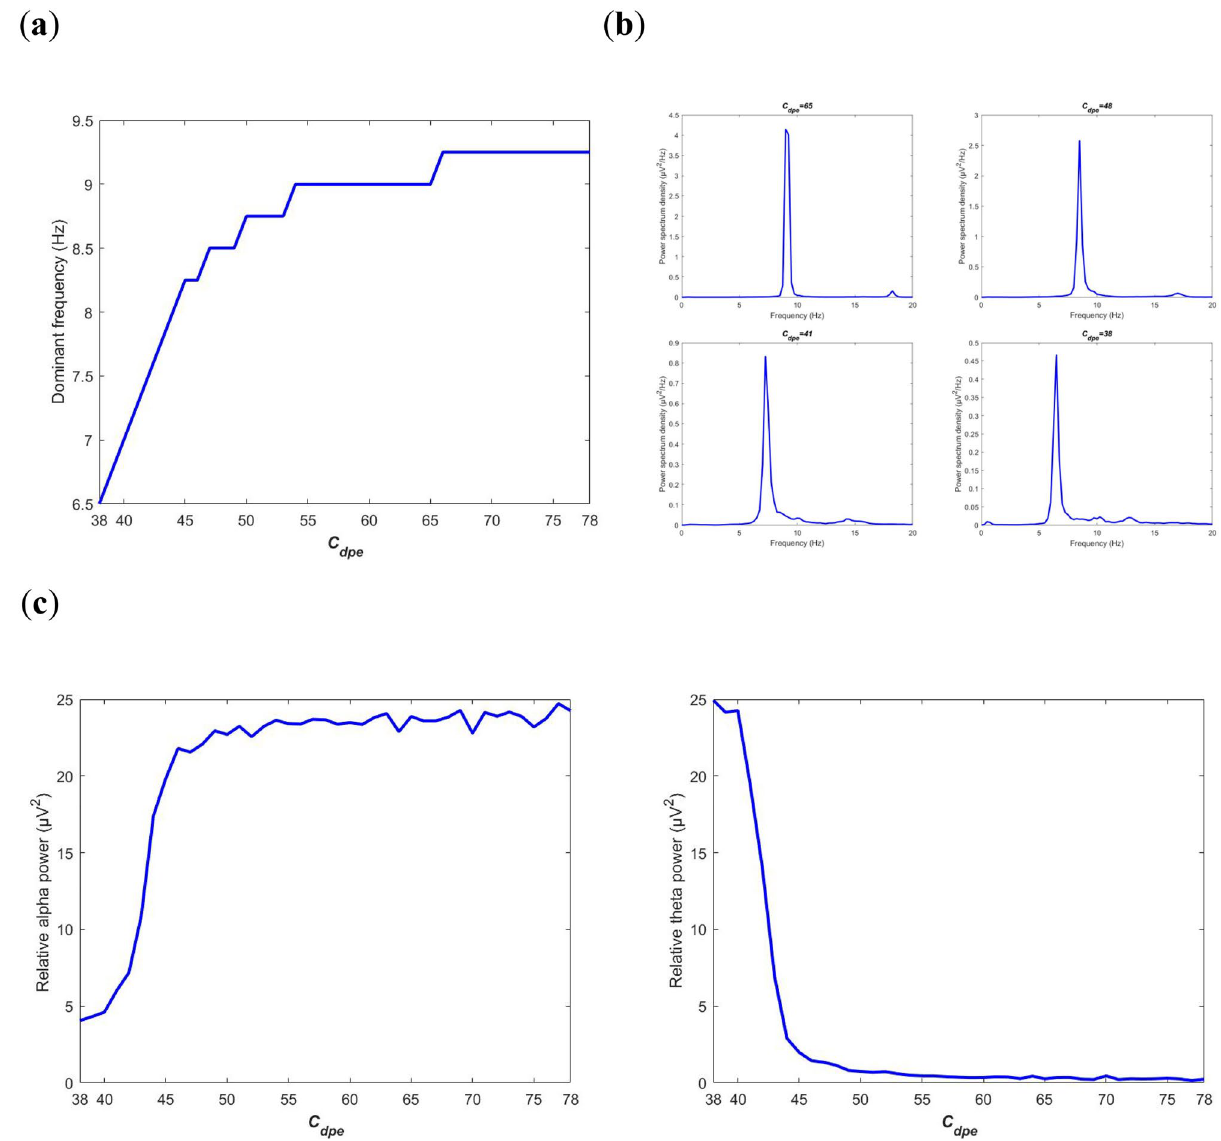
Figure 6. Power spectrum analysis of the BTC model output V t in frequency-domain when the excitatory synapse connectivity parameter C dpe from PY to PNN is varied in the range of[38,78]. ( a ) Dependence of the dominant frequency of the model output on C dpe . ( b ) The power spectrum density when C dpe takes some different values of 65, 48, 41 and 38. ( c ) The evolution of relative power in specific bands: alpha band (left panel) and theta band (right